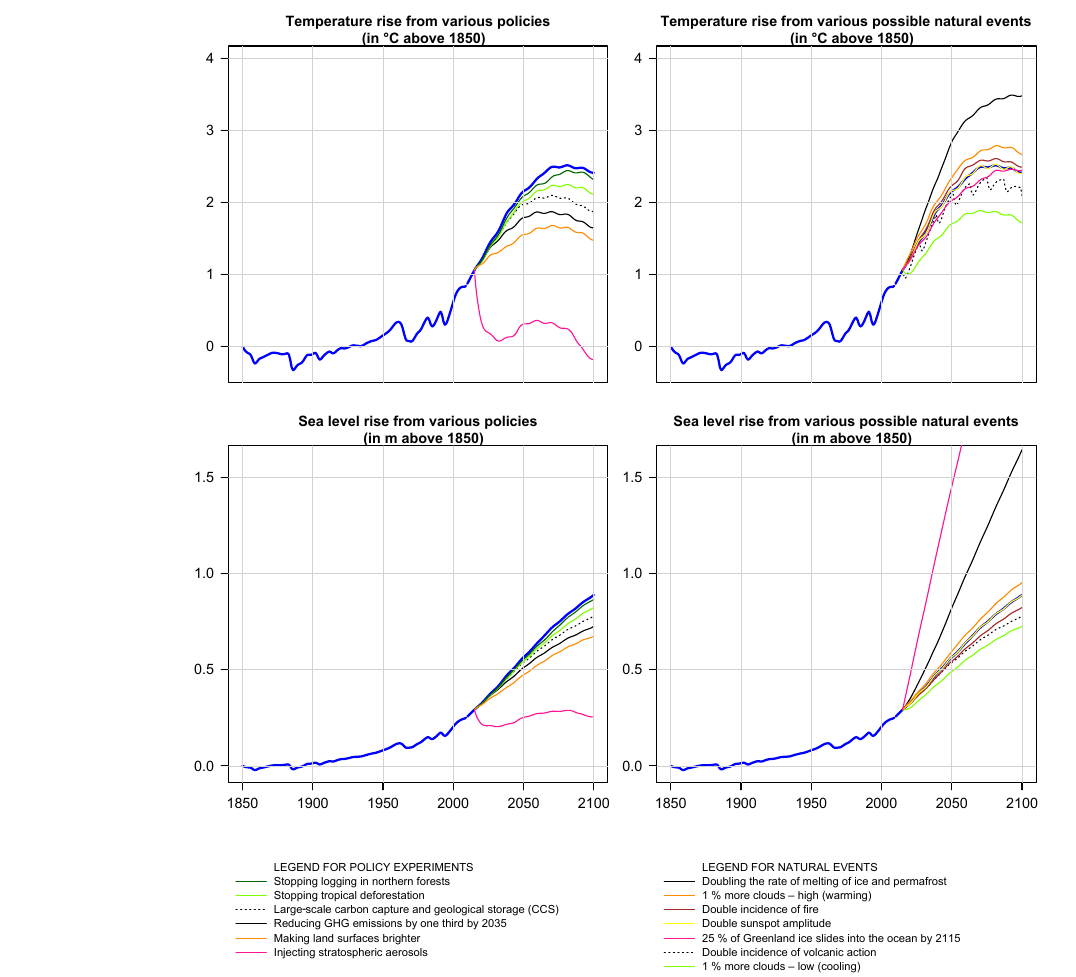
Figure 9. The effect in ESCIMO on the global average surface temperature (top panels) and sea level rise (bottom panels) of various possible policy interventions (left panels) and various natural events (right panels). All changes introduced in the year 2015. World 1850 to